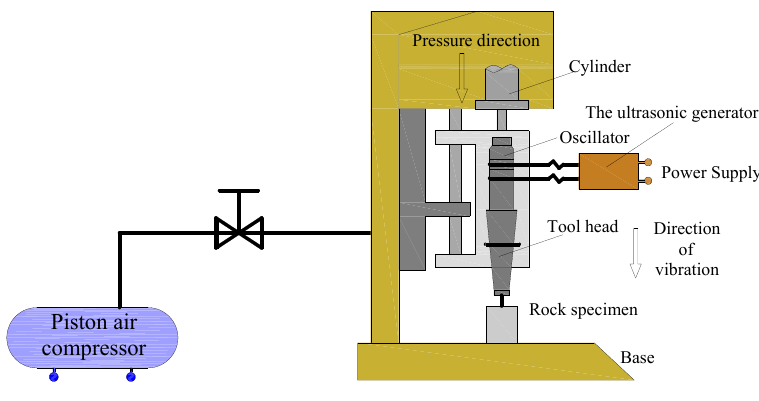
Figure 4. Test setup for ultrasonic excitation loading test. Table 2. Physical experiment schemes.